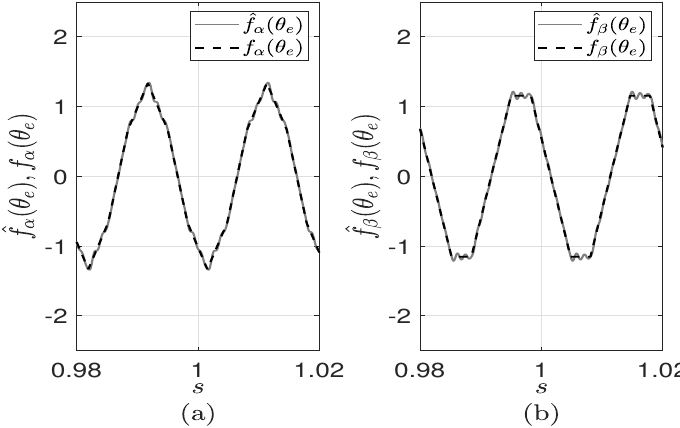
Figure 8. ( a ) Luenberger observer back-EMF function f α estimation; ( b ) Luenberger observer back-EMF function f β estimation.